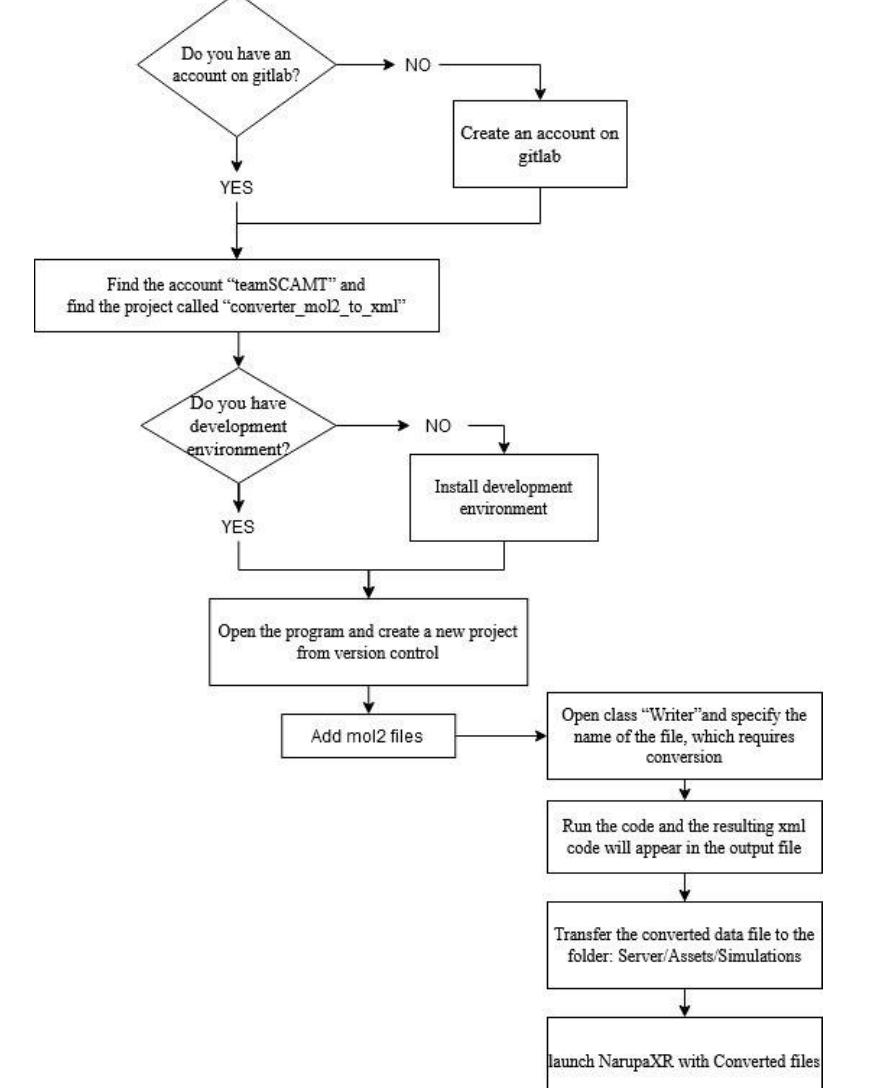
Figure 4. A step by step schematic diagram describing the usage of converter.